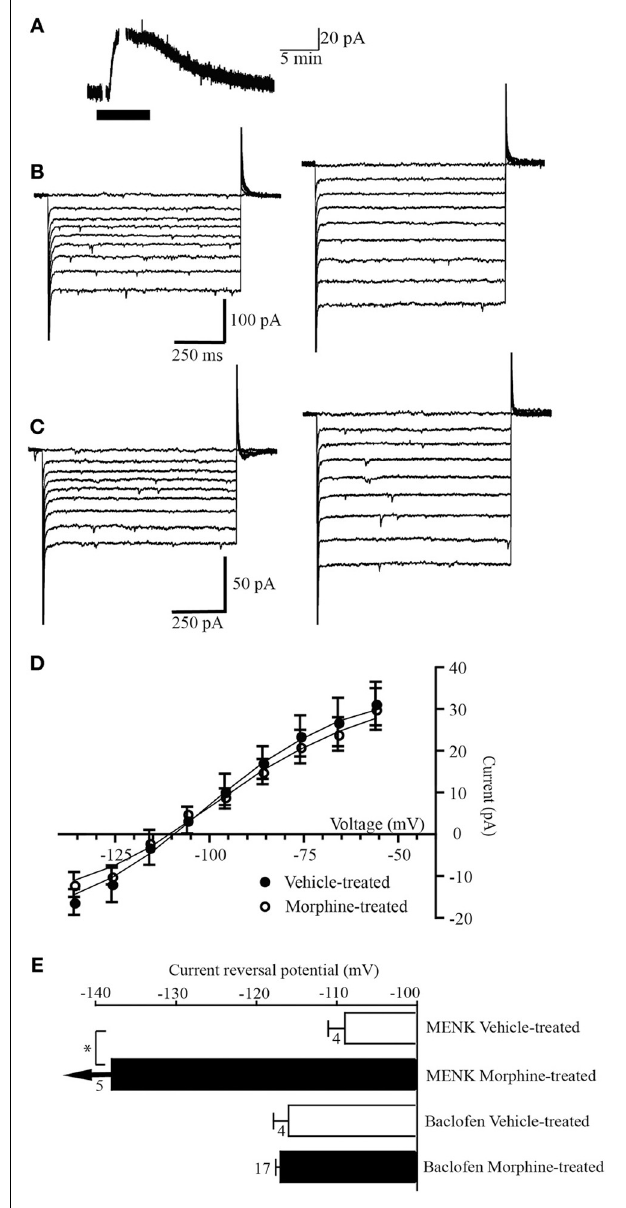
FIGURE 2 | GABA B receptors do not couple to a GAT-1 conductance. (A) Example trace of currents from a neuron voltage clamped at − 56mV (drug superfusion shown by bars). Baclofen (10 μ M) induced an outward current in a neuron from a morphine-treated mouse. (B,C) Currents produced by voltage steps from − 56mV to − 136mV in − 10mV increments in a neuron from (B) a vehicle-treated mouse and (C) a morphine-treated mouse before (left) and during baclofen (10 μ M) application (right). (D) Subtracted current-voltage relationships for baclofen (current in baclofen–current during control conditions). Reversal potentials were determined at the point where they cross the abscissa. The baclofen current reversed polarity near E K in neurons from vehicle-treated ( n = 8 ), and morphine-treated mice ( n = 17 ). (E) Reversal potential of the MENK and baclofen-induced currents in cells from vehicle-treated and chronic morphine-treated mice. Arrows indicate that the average current did not reverse polarity at the most negative potential that could be tested ( − 136mV). The number of neurons is shown beside the bar. ∗ P -value of 0.034, Students t